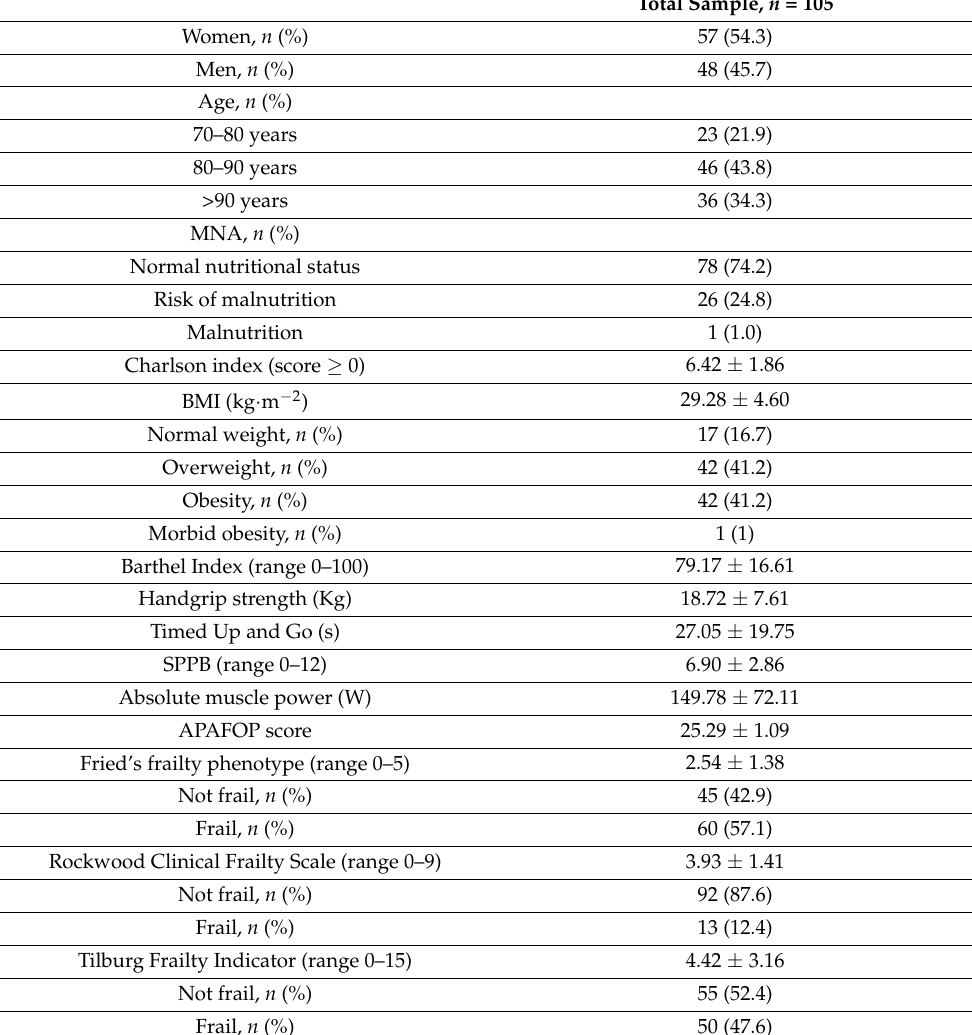
Table 1. Participant